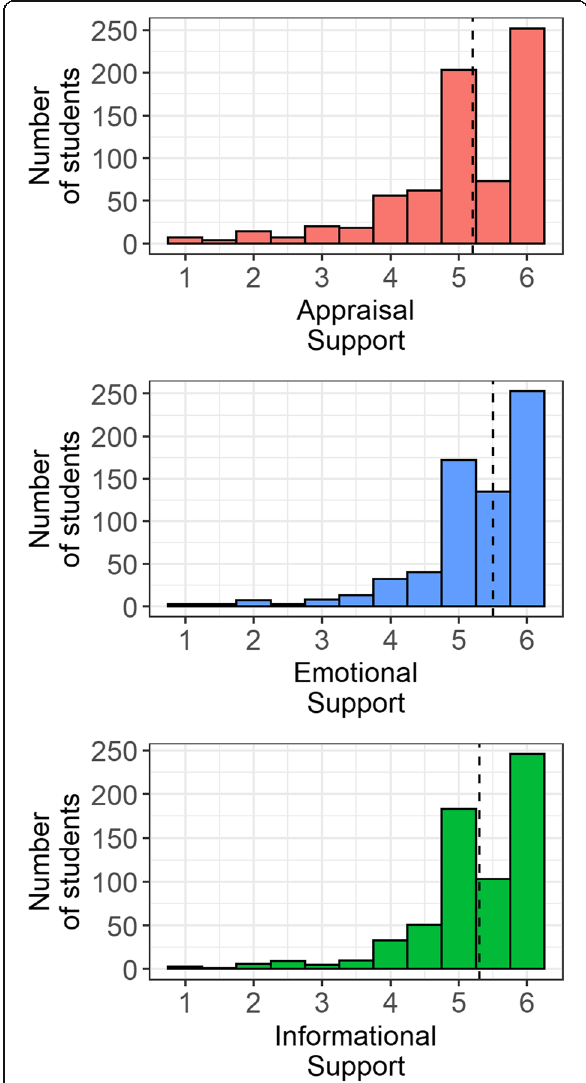
Fig. 2 Distribution of students ’ perceptions of appraisal, emotional, and informational social supports they receive from LAs. The dotted line represents the median response value. Each item was scored on a 6-point Likert scale (strongly disagree [1], disagree [2], somewhat disagree [3], somewhat agree [4], agree [5], strongly agree [6])